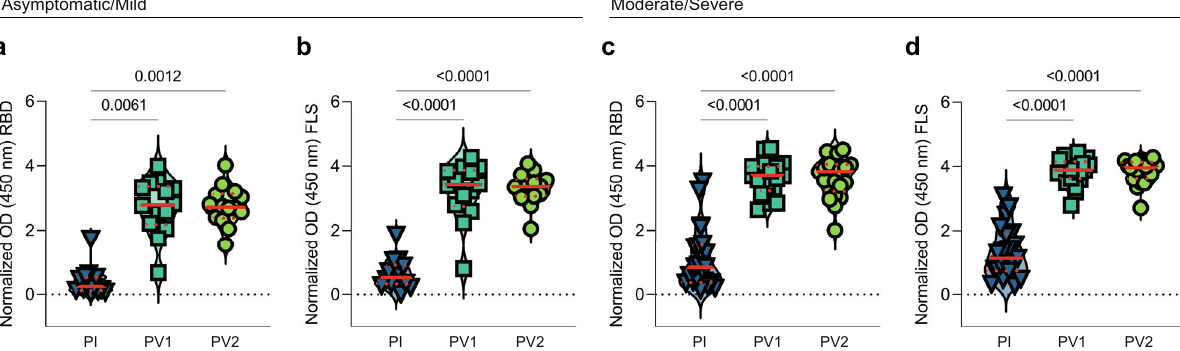
Fig. 1 Humoral responses against SARS-CoV-2 RBD and FLS after COVID-19 infection and subsequent vaccination. Plasma was diluted 1:500 and circulating a anti-RBD and b anti-FLS IgG Ab from those with asymptomatic/mild symptoms ( n = 14) or c anti-RBD and d anti-FLS IgG Ab from those with moderate/severe symptoms ( n = 21) were measured post infection (PI) and after fi rst (PV1) and second (PV2) vaccinations. P values were calculated using Friedman ’ s test with Dunn ’ s multiple comparisons test and are shown above horizontal lines spanning comparison groups when signi fi cant. Red lines bisecting groups represent median (solid) with IQR (dotted).